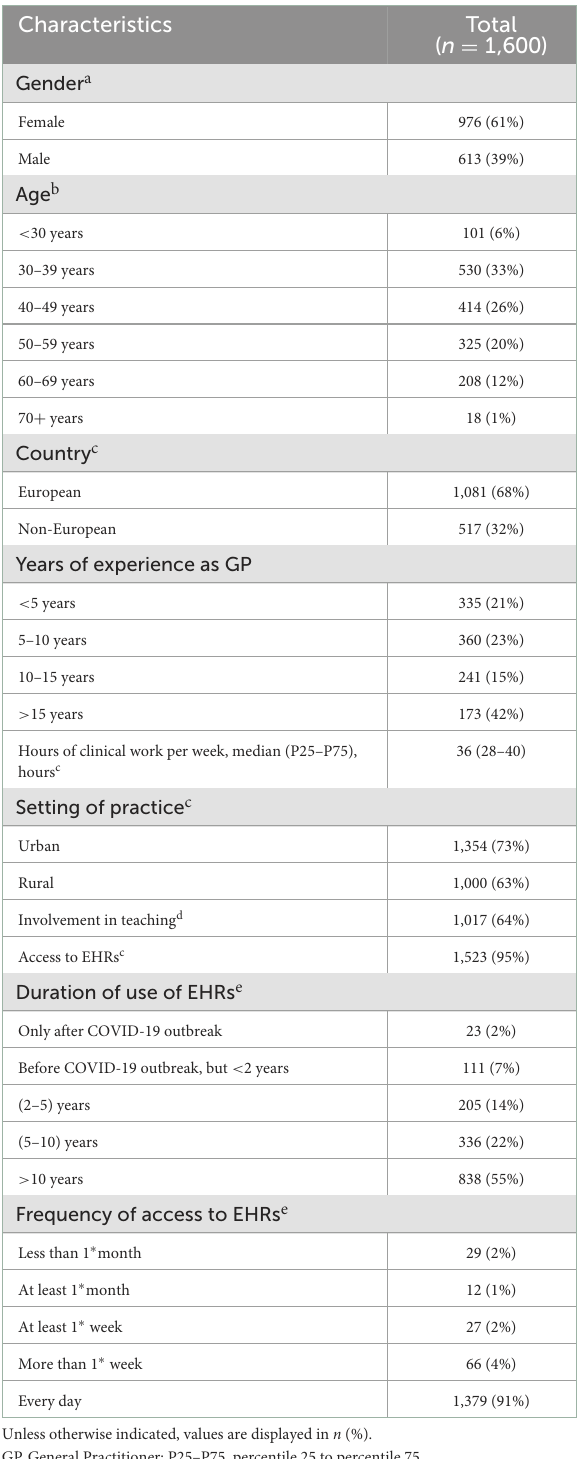
TABLE 1 Participants characteristics ( n =